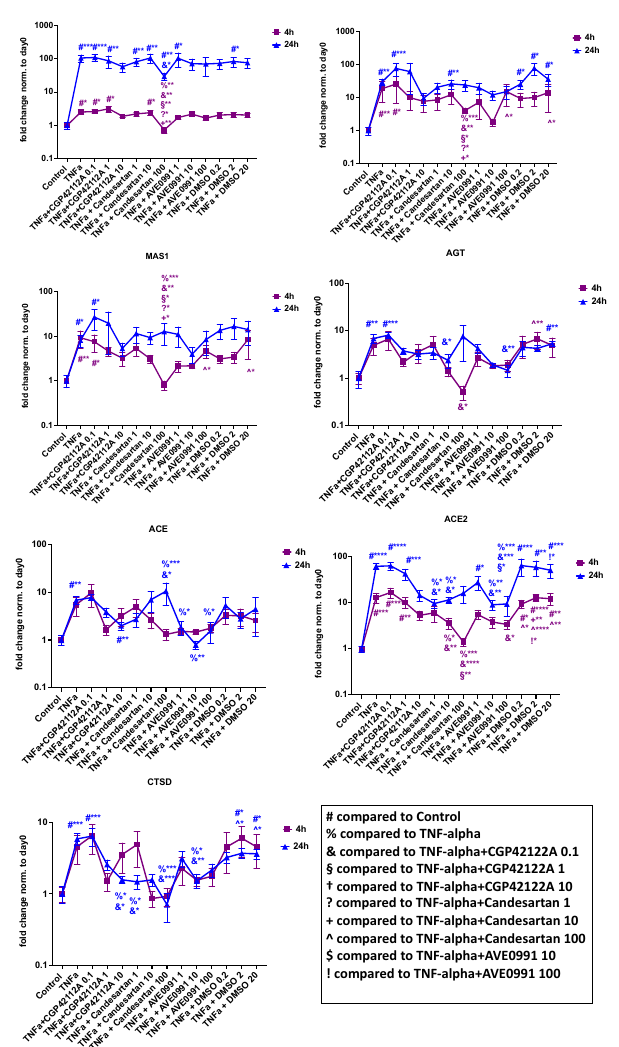
Figure 8. Gene expression analysis of tRAS markers in human NP cells for candesartan (1 µ M, 10 µ M, 100 µ M), the MAS-receptor agonist AVE 0991 (1 µ M, 10 µ M, 100 µ M), and the AGTR2-receptor agonist CGP-42112A (0.1 µ M, 1 µ M, 10 µ M) with 4 h and 24 h of exposure in inflammatory settings (TNF- α addition). DMSO (0.1 µ L/mL, 1 µ L/mL, 10 µ L/mL; shown in µ L volume on the x -axis) was used as the solvent control. Fold change values normalized to the baseline (day 0) are shown. n = 4